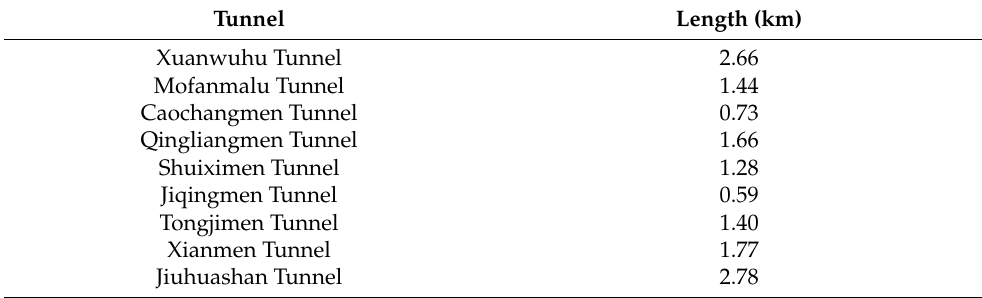
Table 1. Experimental tunnel length